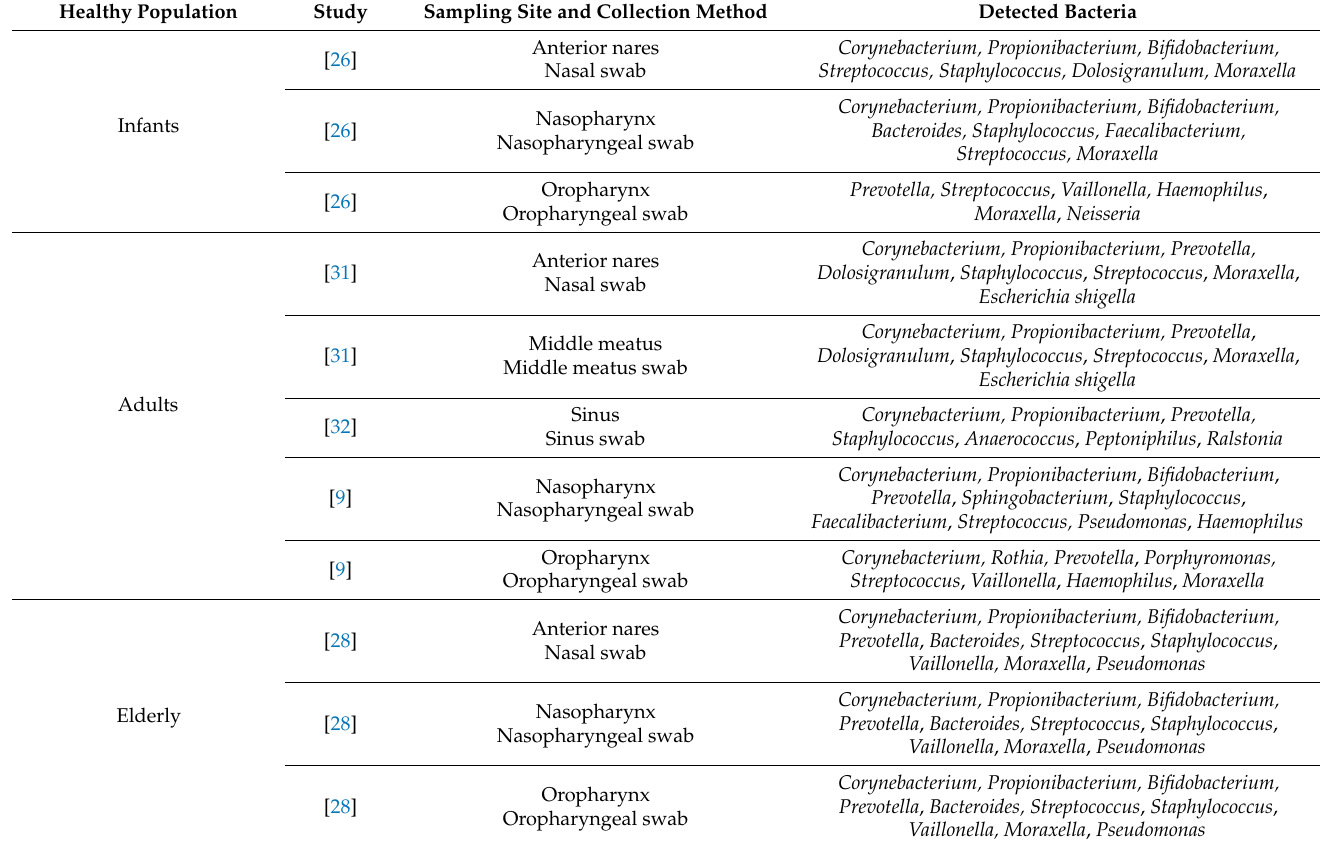
Table 1. Detected UA bacteria across age in a healthy